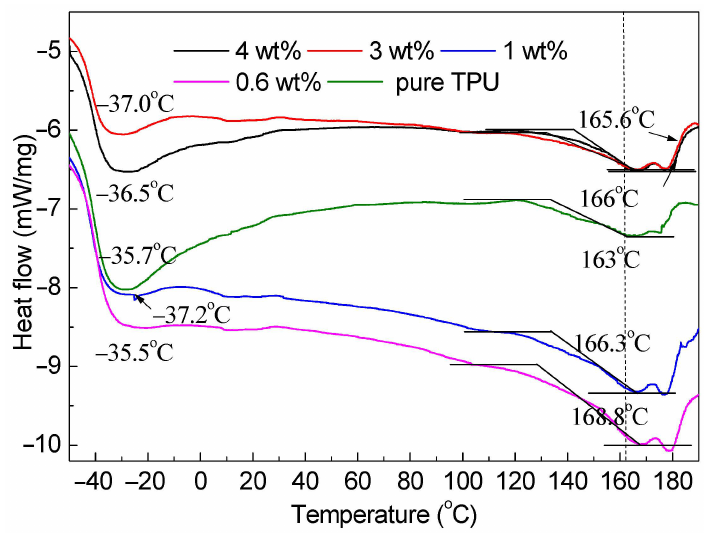
Figure 5. DSC measurements of pure TPU and GO-TPU films prepared with the loading of GO of 0.6 wt %, 1 wt %, 3 wt %, 4 wt %, respectively. Numbers in plot stand for the glass transition temperature and melting